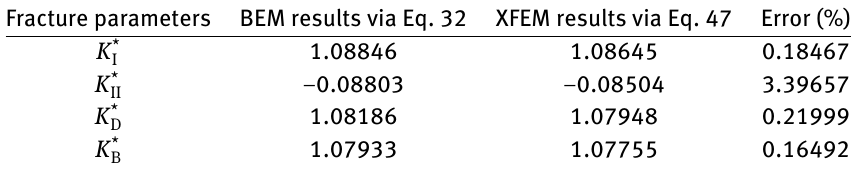
Table 2: Fracture parameters of a MEE interface crack for V I f = 0.5 and V II f = 0.2 Fracture